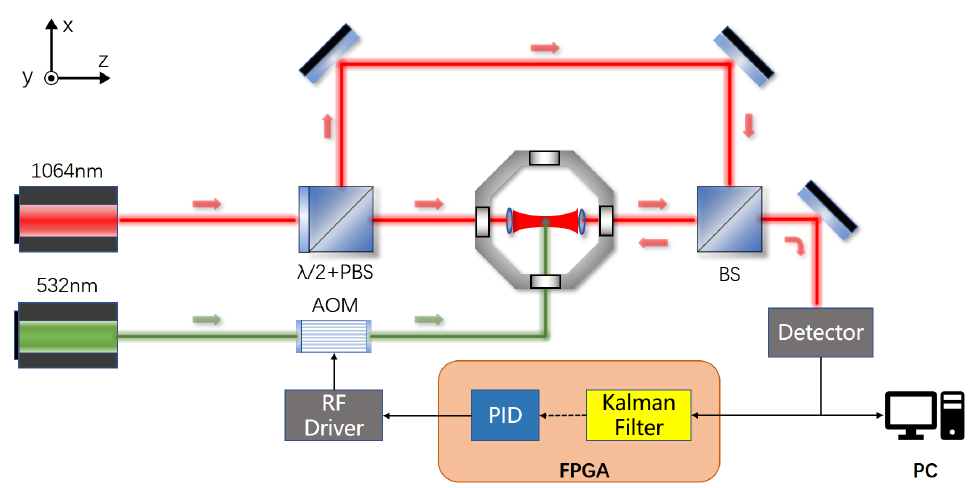
Figure 1. Schematic of trapping and feedback cooling in a vacuum optical trap. Only a single-axis detection and cooling system diagram is shown here.